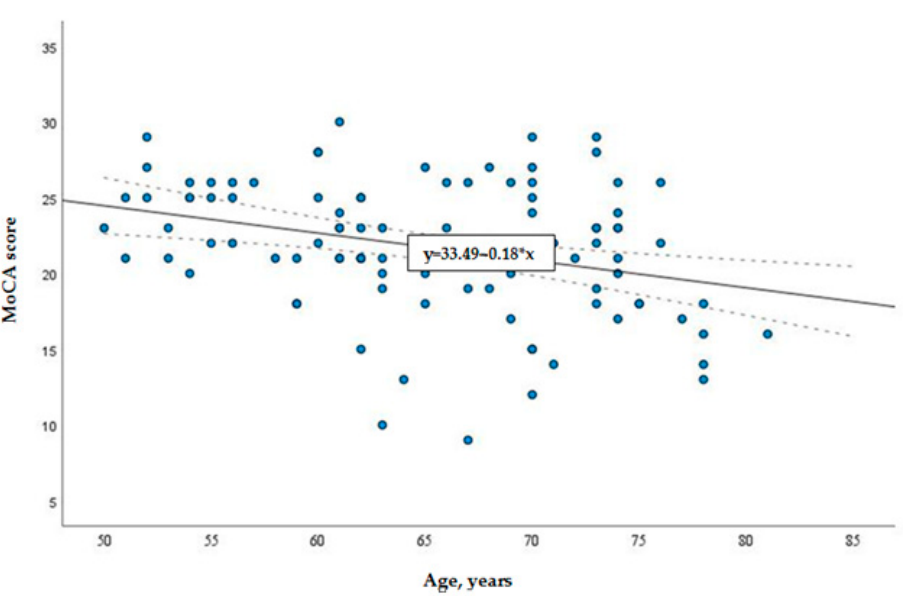
Figure 3. Linear correlation of age with MoCA score.